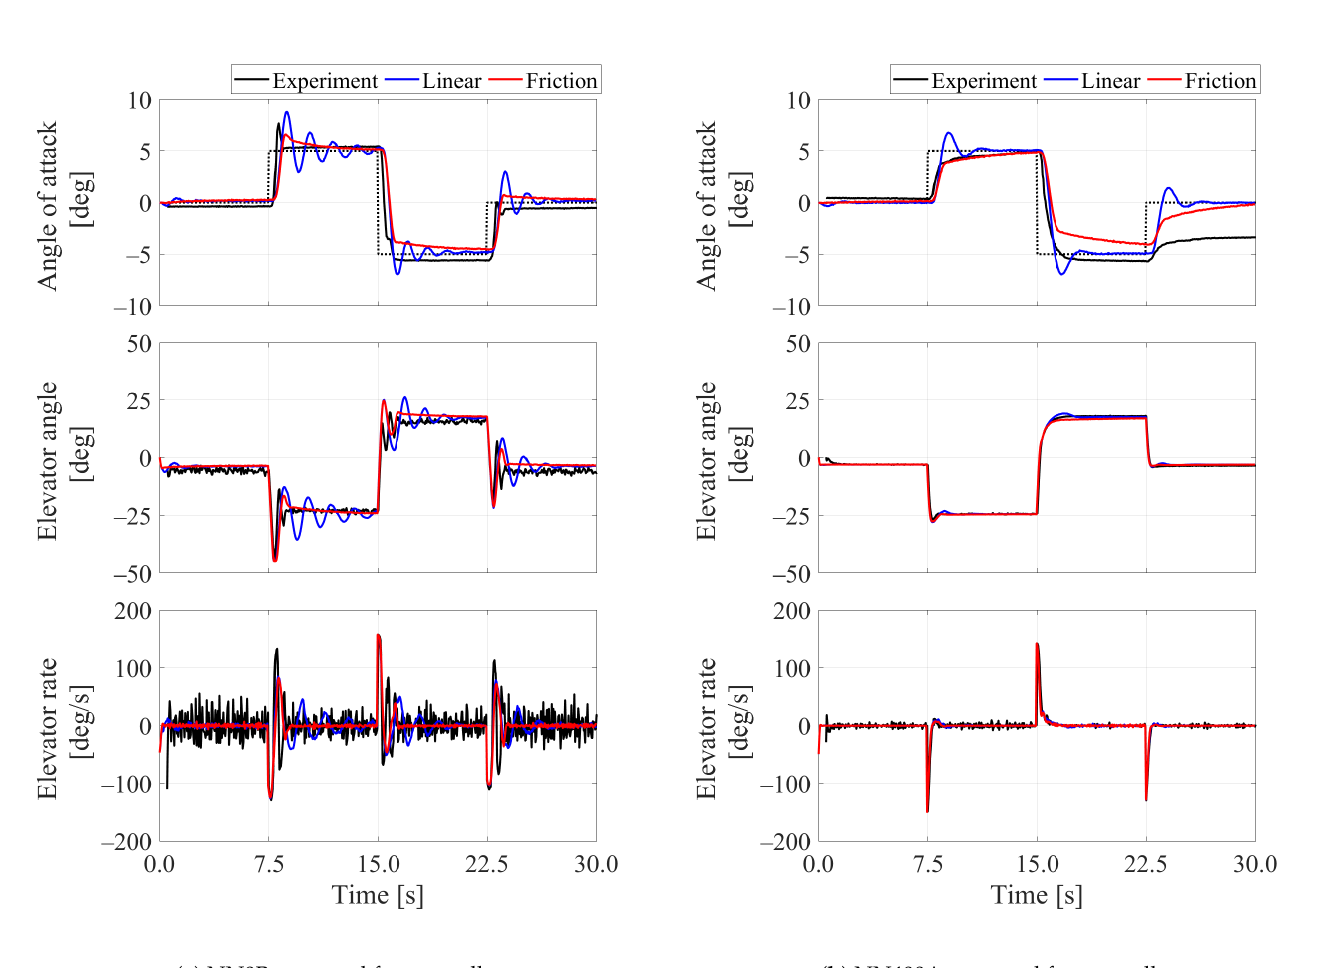
Figure 12. Experimental and simulated angle of attack, elevator angle and elevator rate histories. Wind speed was 12m/s. Applied time delay in simulation was t 0 = 250ms. The doublet angle-of-attack schedules are plotted with black dotted lines. The black, blue and red lines indicate the results of the experiment, simulation with linear model and simulation with friction model,